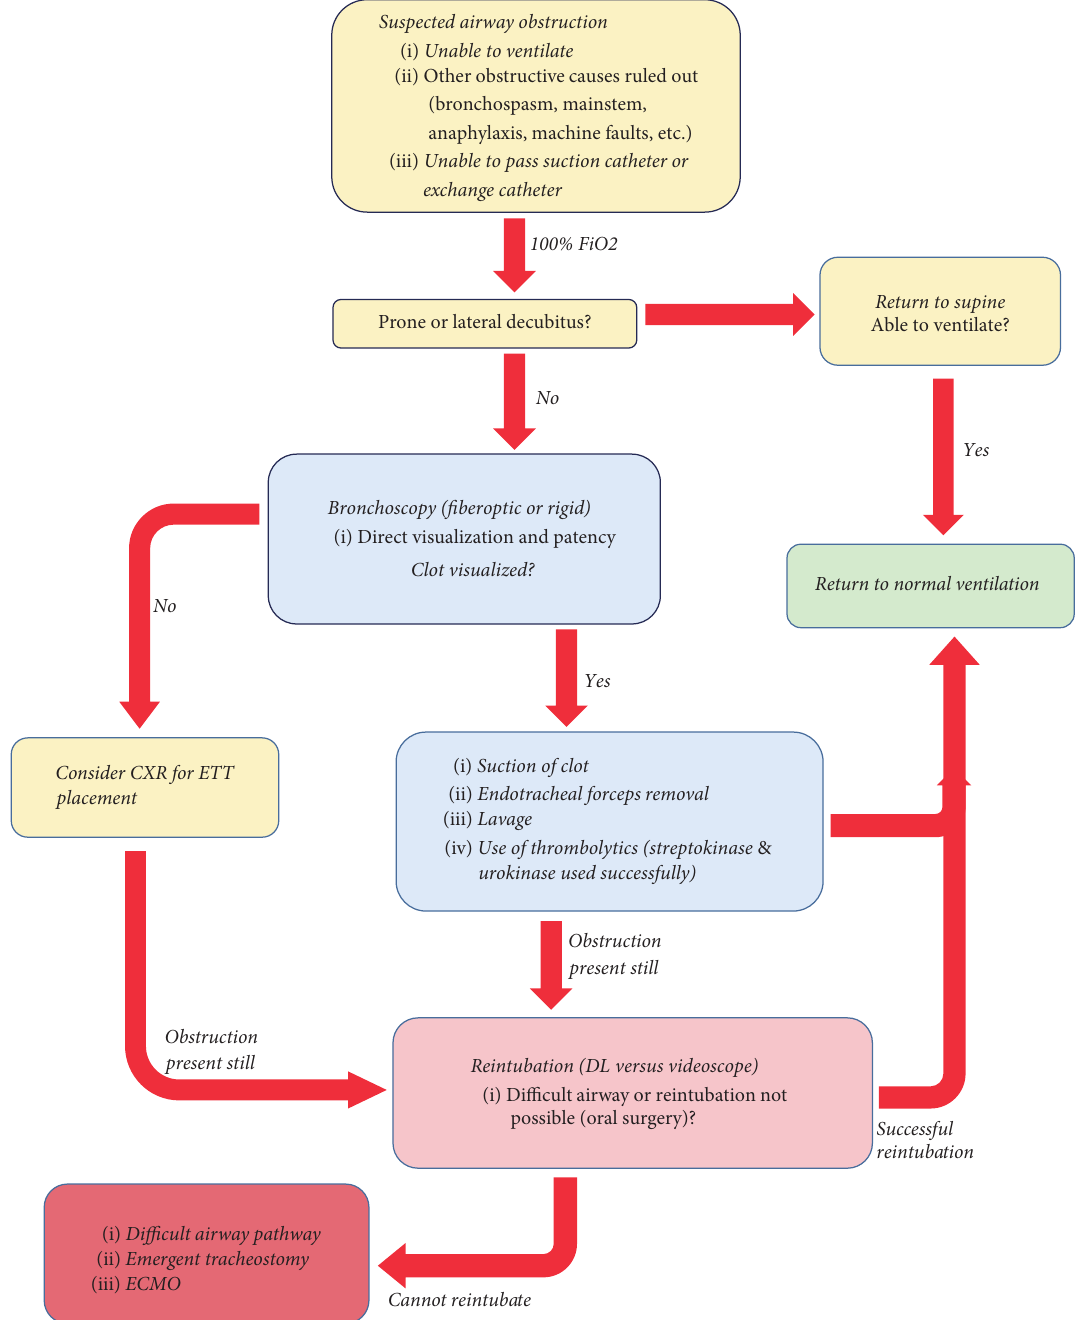
Figure 3: Proposed flowchart for suspected complete ETT